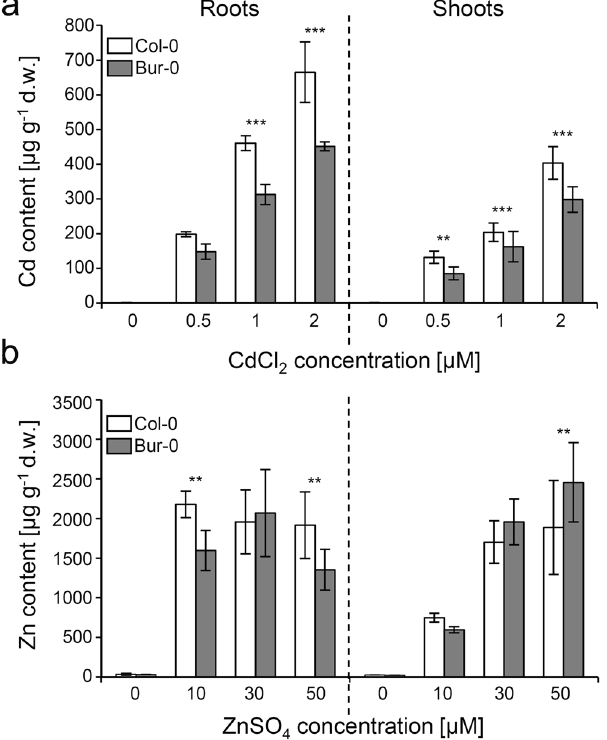
Figure 4. Cd and Zn accumulation differ in hydroponically cultivated Col-0 and Bur-0 plants. Cd ( a ) and Zn ( b ) content of hydroponically grown Col-0 (white bars) and Bur-0 (grey bars) plants was determined in roots (left) and shoots (right) after six weeks of growth. For the last week of cultivation, different concentrations of CdCl 2 and ZnSO 4 , respectively, were added to the medium. Data represent means ± SD of 3 independent experiments (n = 6, i.e. two sample pools per plant line and condition). Statistical analysis was performed by one-way ANOVA and subsequent Tukey test. The asterisks indicate significant differences between the accessions ( *** P < 0.001; ** P < 0.01), 95% confidence